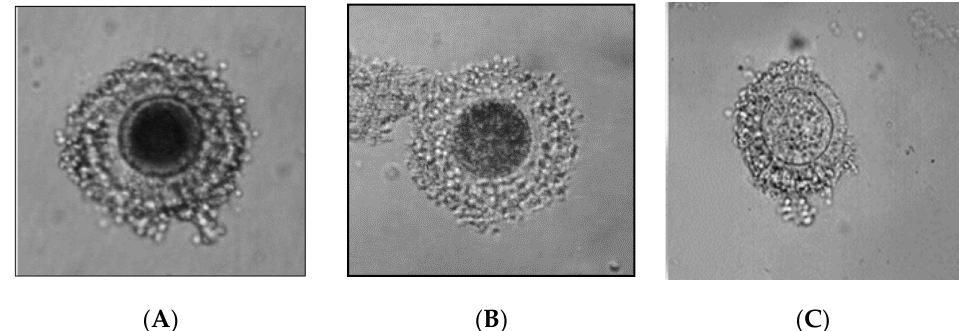
Figure 1. Oocyte classification based on the color of the cytoplasm; ( A ) oocyte with very dark cytoplasm ( B ) oocyte with dark, mosaic cytoplasm, ( C ) oocyte with pale cytoplasm .